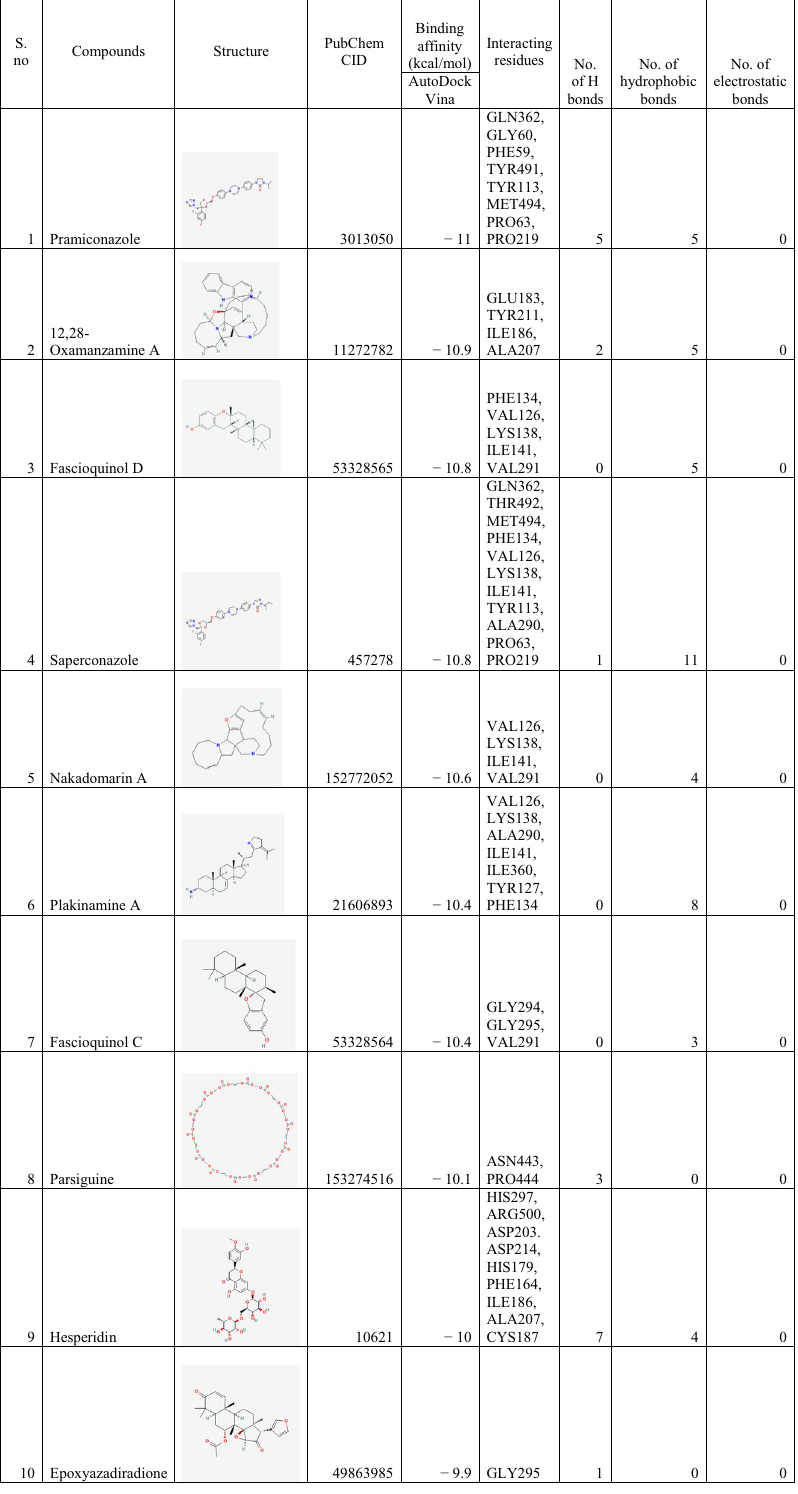
Table 5 The binding affinity and interaction pattern analysis of top 10 ligands docked with Lanosterol 14 alpha-demethylase S. no